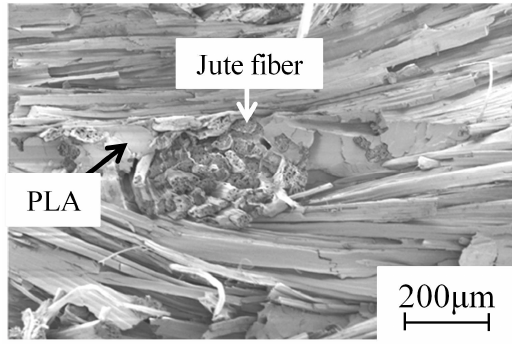
Figure 7. Fiber pull out in fracture surface of green composite at 0 cycles.